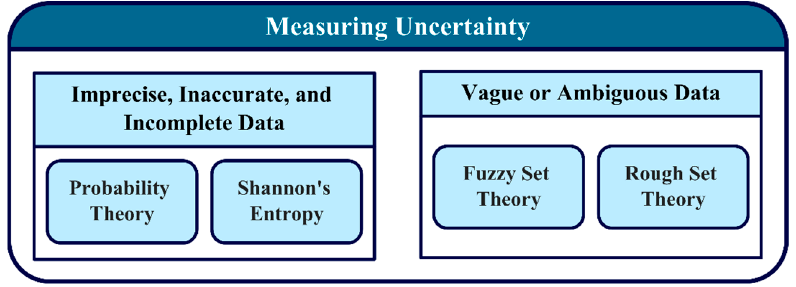
Figure 4. Common approaches for measuring uncertainty (Source: [36]).